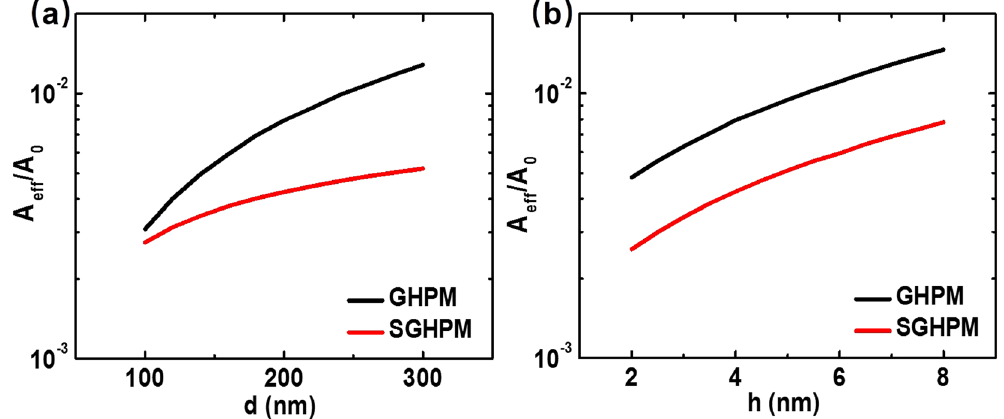
Figure 7. The normalized effective mode area ( A eff /A 0 ) varies with the cylinder diameter d and the dielectric gap thickness h for the GHPM (black lines) and SGHPM (red lines), respectively. ( a ) The cylinder diameter d varies from 100 to 300 nm where h = 4 nm and h d = 50 nm. ( b ) The dielectric gap thickness h varies from 2 to 8 nm where d = 200 nm and h d = 50